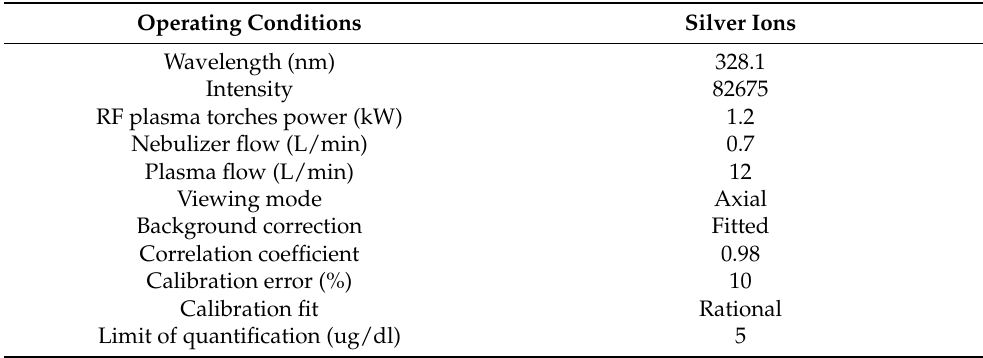
Table 1. Operating conditions for the determination of silver ions by inductively coupled plasma– optical emission spectrometer